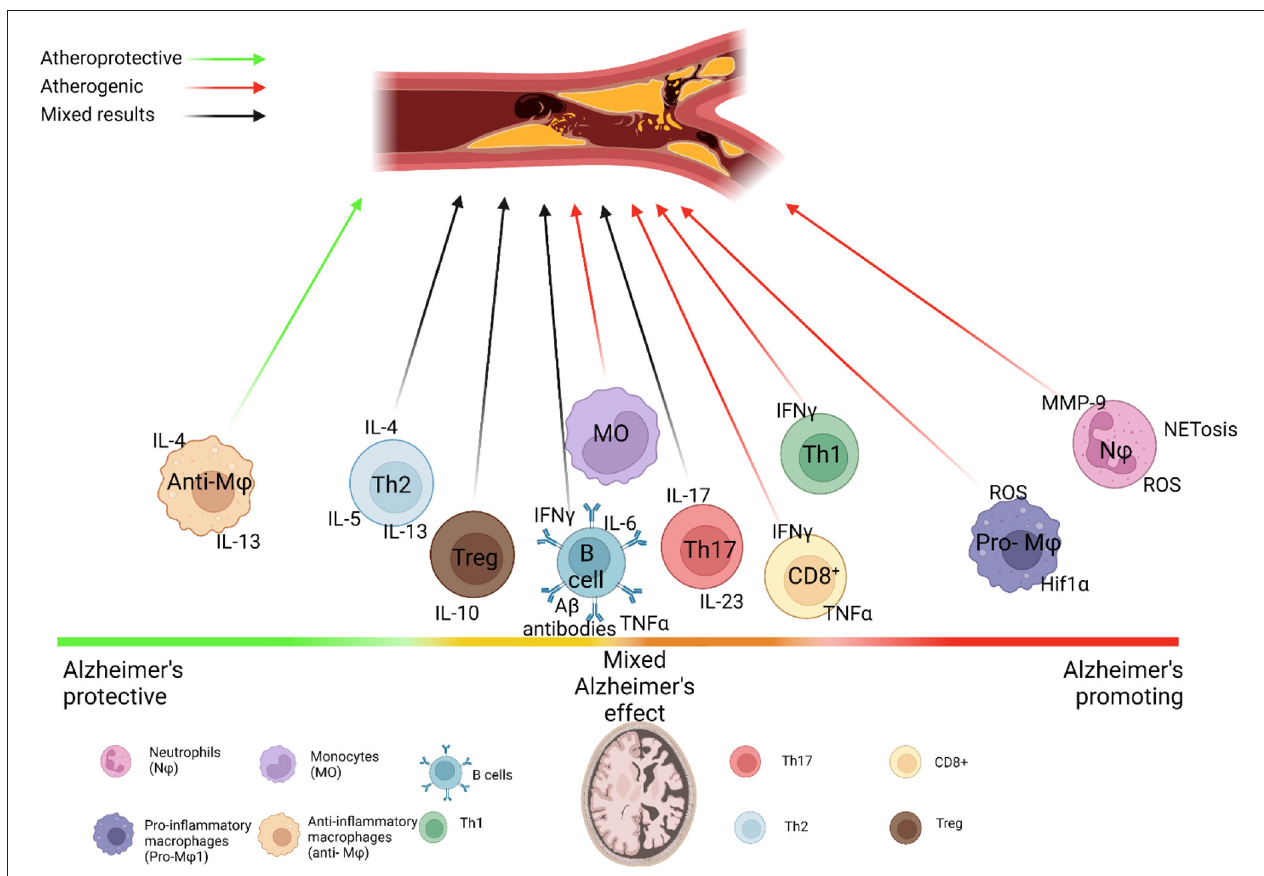
FIGURE 1 | Immune system dysfunction links Alzheimer’s and Atherosclerosis. Immune cell subsets vary in their interactions with Alzheimer’s disease (AD) and Atherosclerosis. Neutrophils drive both AD and atherosclerosis through their aggregation and production of MMPs, ROS and NETs, which damage the blood brain barrier and heighten hypoxia-induced A β production, while the neutrophilia and increased activation of neutrophils seen in atherosclerosis may further feed into this damage. Monocytes phagocytize A β , but may also produce proinflammatory cytokines that drive harmful neuroinflammation, while the production of pro-inflammatory monocytes is increased in atherosclerosis, which accelerates atherogenesis. Both diseases drive differential production of classical and non-classical monocytes. TREM2 + macrophages may help to clear A β in the brain and mitigate inflammation in atherosclerotic lesions. Similarly, increased proportions of anti-inflammatory macrophage subsets appear to play a protective role in AD, while increased proportions of proinflammatory macrophages drive inflammasome activation and production of pro-inflammatory cytokines in atherosclerosis, causing plaque progression. Adaptive immune cells add further complexity to these diseases. The role of B cells in AD and atherosclerosis appears to be subset specific, with clearance of A β via antibodies tempered by the release of pro-inflammatory cytokines and differential effects by follicular B cells and innate response activator B cells on atherosclerosis. This is similar to the differential activity of T cells in these diseases. Controversy over the role of regulatory T cells in AD revolves around whether immune tolerance or immune activation is beneficial for AD. Th1 cells are prominent in progression of atherosclerosis and AD, producing high levels of IFN γ , which increases risk of plaque rupture in atherosclerosis and blood brain barrier breakdown